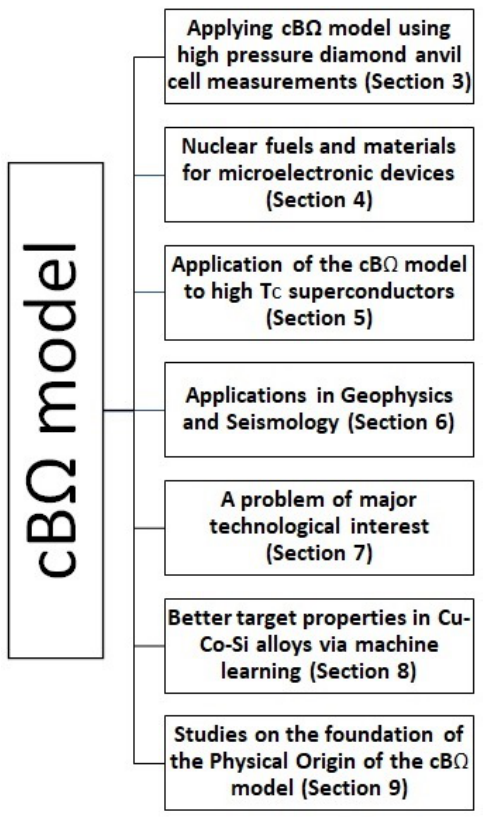
Figure 1. A block diagram summarizing the applications of cB Ω model discussed